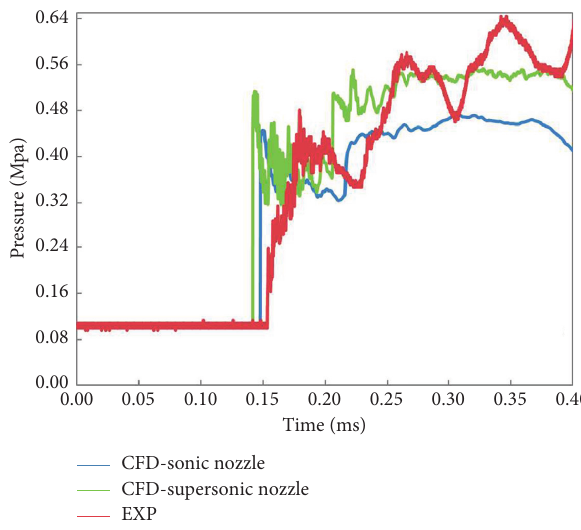
Figure 9: Pressure histories at the exit of sonic and supersonic